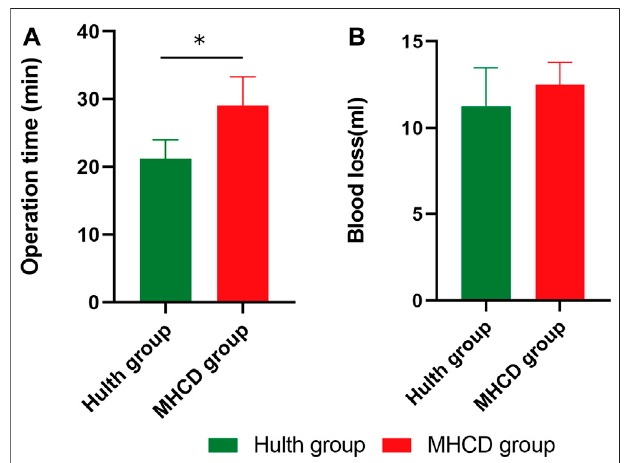
FIGURE2 | Evaluationof operation time (A) and blood loss (B) in rhesus macaques subjected to the Hulth and MHCD methods. * p < 0.05. Data are presented as the mean ±